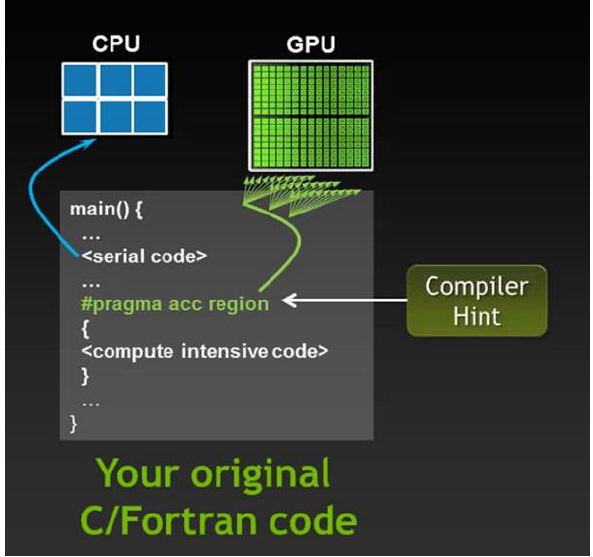
Fig. 2. Compiler hint